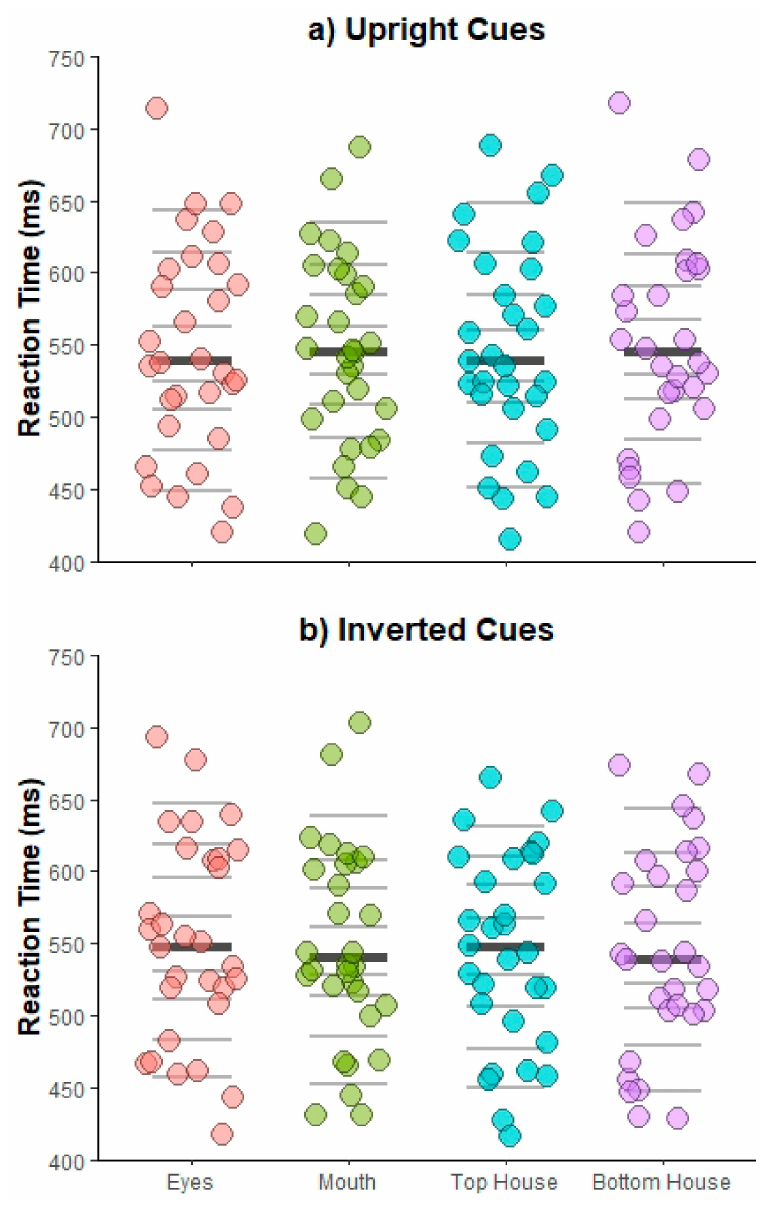
Figure 4. Experiment 2 manual results. Stripcharts depicting mean correct RTs for each participant as a function of target position for Upright ( a ) and Inverted ( b ) cues. Horizontal lines mark the deciles, with the thicker darker line representing the